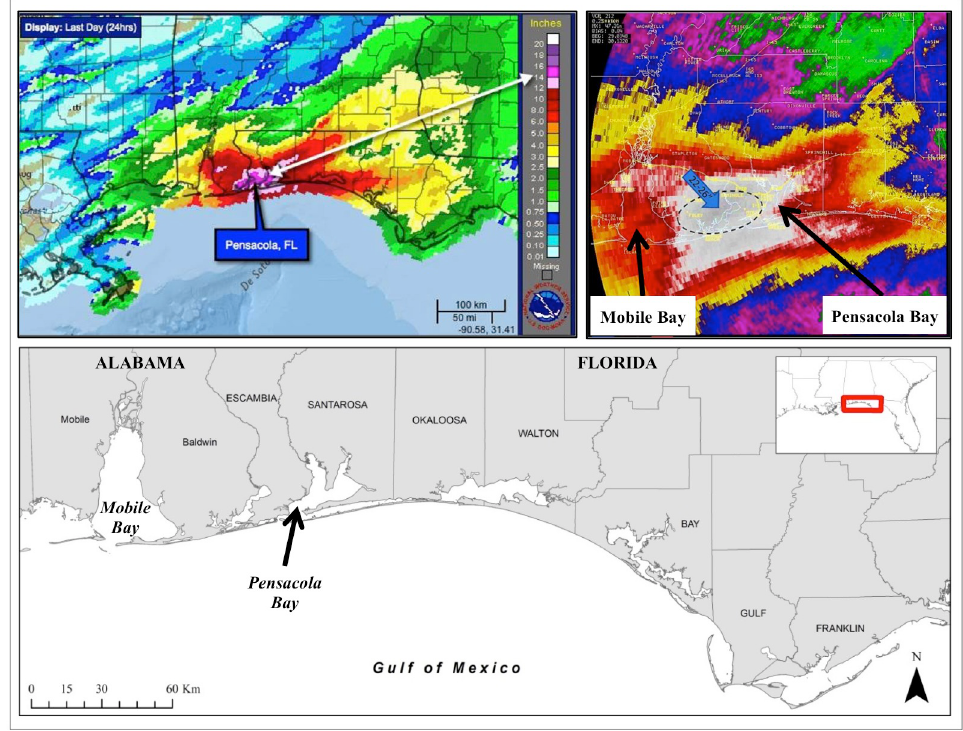
Fig 1. Geographic extent and radar from historic flood event, April 2014. Top left: estimated total rainfall over the two-day event, between 8:48pm on Monday April 28 th and 9:20am on Wednesday, April 30 th ; Top right: 24-hour radar estimated rainfall between 9am Tuesday, 29 April– 9am Wednesday, 30 April, zoomed in to show the most impacted region; Bottom: Stranding data coverage area and Pensacola Bay study site location; Figures obtained from